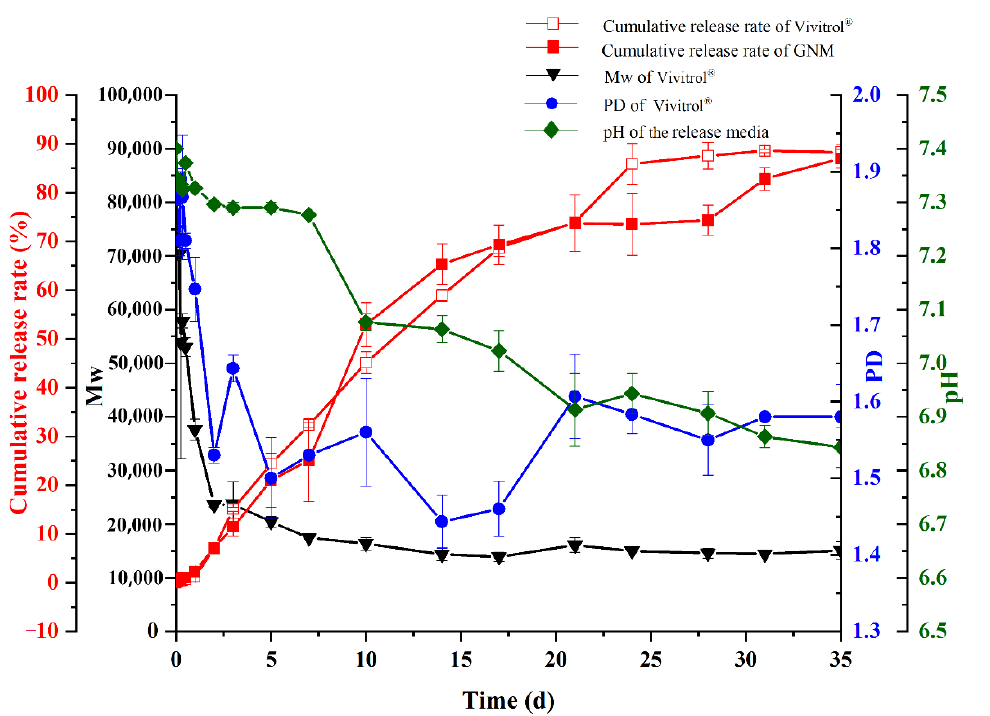
Figure 9. In vitro release of Vivitrol ® and GNM.